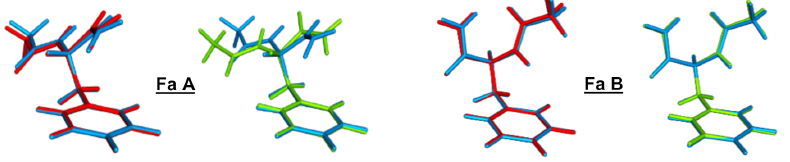
Figure 3. Optimized geometries of the S 1 state for Fa A and B. Comparison of the CC2/cc-pVDZ geometry (blue structures) with that obtained with ω B97XD/cc-pVDZ (red structures) and with CAM-B3LYP/cc-pVDZ (green structures). For the sake of comparison, phenyl rings were overlapped. On the contrary, the optimized geometry of the ground state of Fa A (S 0 , see Table S6a–c) obtained with CAM-B3LYP did not present such large deviations. The discrepancies from 0 to 5 ◦ for the dihedral angles with a MAD of 5 ◦ and from − 0.05 to 0.12 Å for the